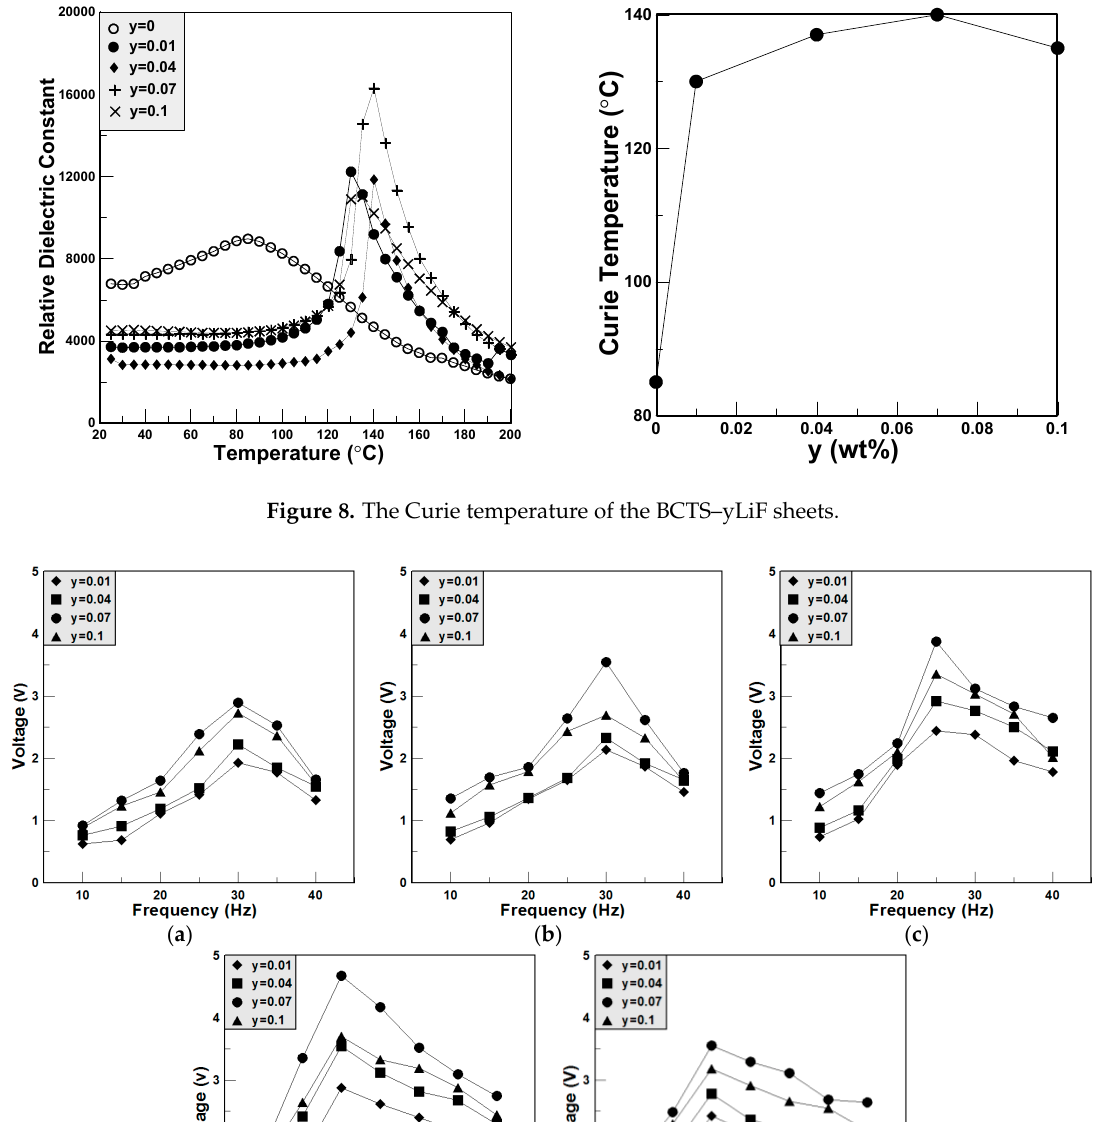
Figure 8. The Curie temperature of the BCTS–yLiF sheets.